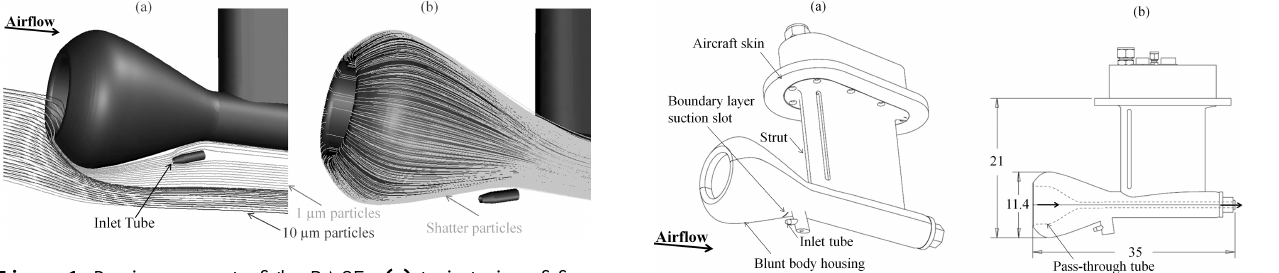
Figure 1. Design concept of the BASE; (a) trajectories of free- stream particles around the sampler. Larger particles (10µm diam- eter) are deflected from the inlet tube region while interstitial parti- cles navigate around the blunt body and are present in the inlet tube region. (b) Shatter particles generated at the surface of the blunt body housing. These particles stay close to the surface of the body and do not enter the aerosol sample.